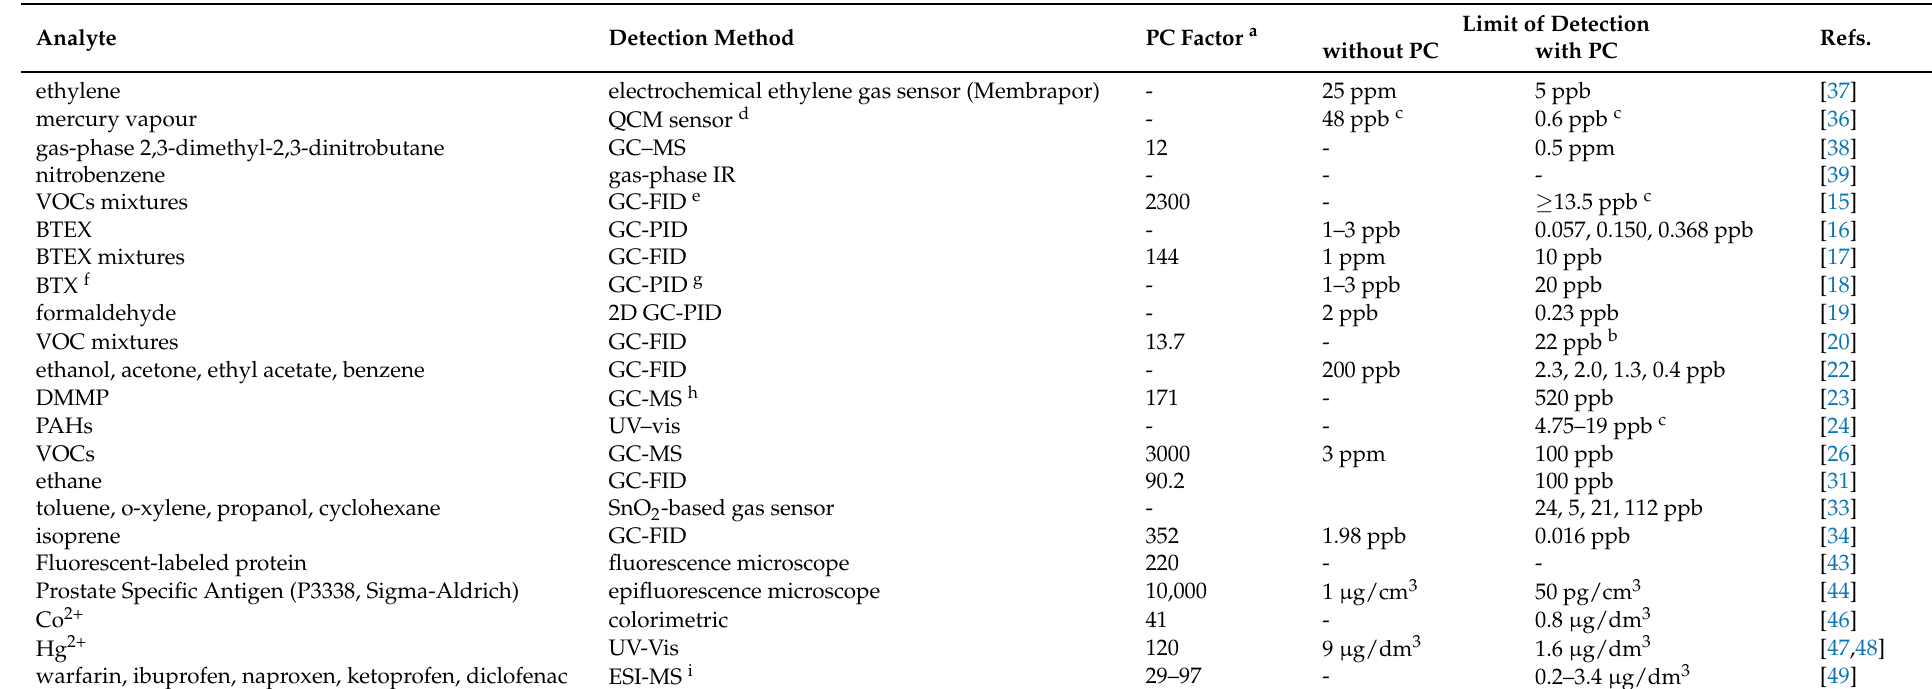
Table 1. Summary of the preconcentrated analytes and performance achieved by various reviewed µ PCs